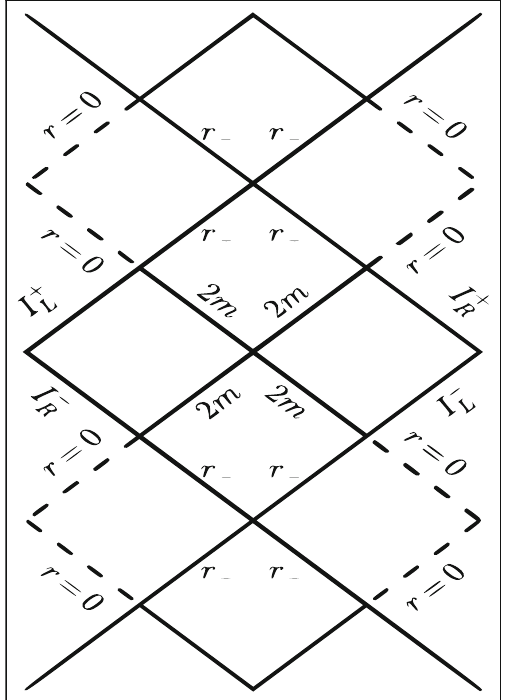
Fig. 1 Carter–Penrose diagram for the self-dual black hole solution. The LQBH scenario is endowed with two asymptotic flat regions, one placed at the infinity and the other one near the origin. The second region can not be reached by any observer in a finite time